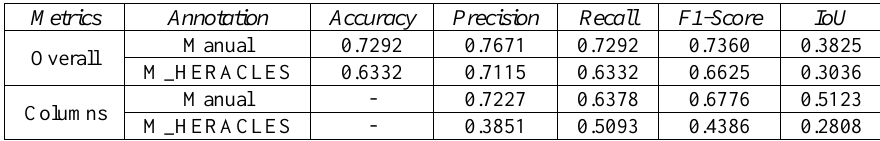
Table 3. Results of the tests performed on the first scenario.